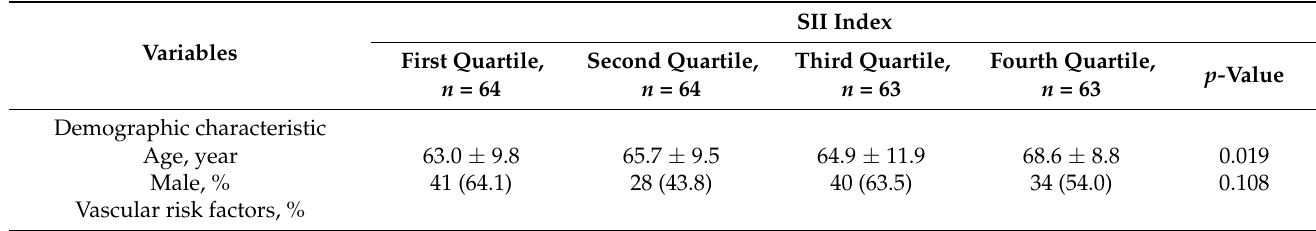
Table 1. Baseline characteristics of the study sample stratified by SII